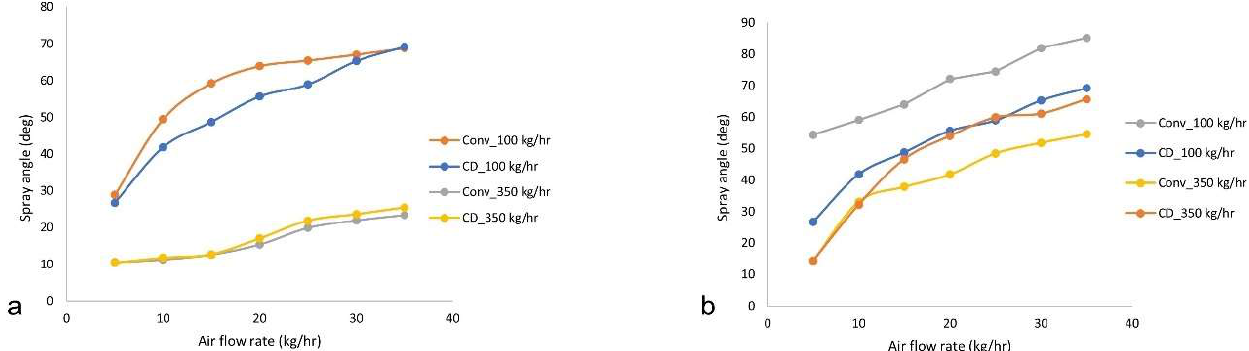
Figure 10. Spray angle measurement for both the converging and converging–diverging (CD) atomizer case with 70 and 280 µm sheet thickness.